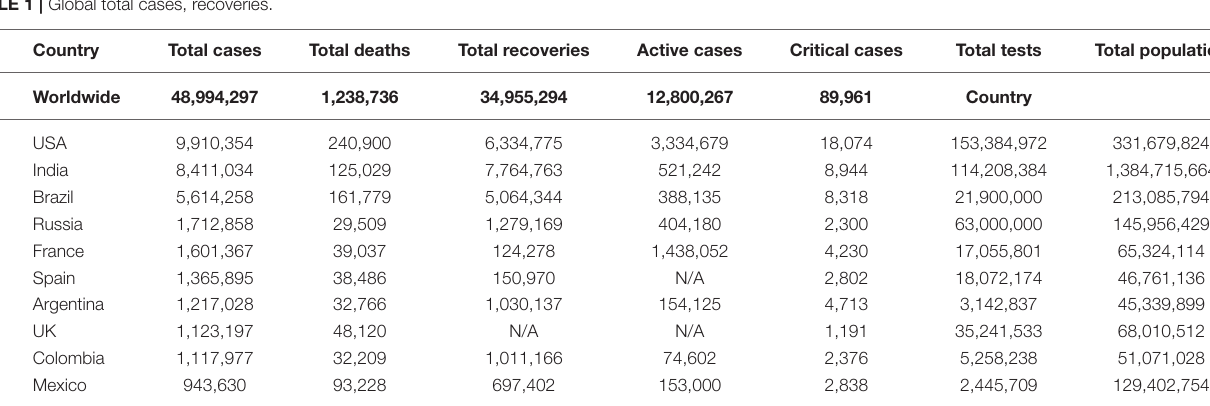
6,552 deaths with 2.12% fatality, which is much lower than the global average rate (3.6%). The COVID-19 virus has caused over 36.84 million positive patients and 1,067,560 deaths. There